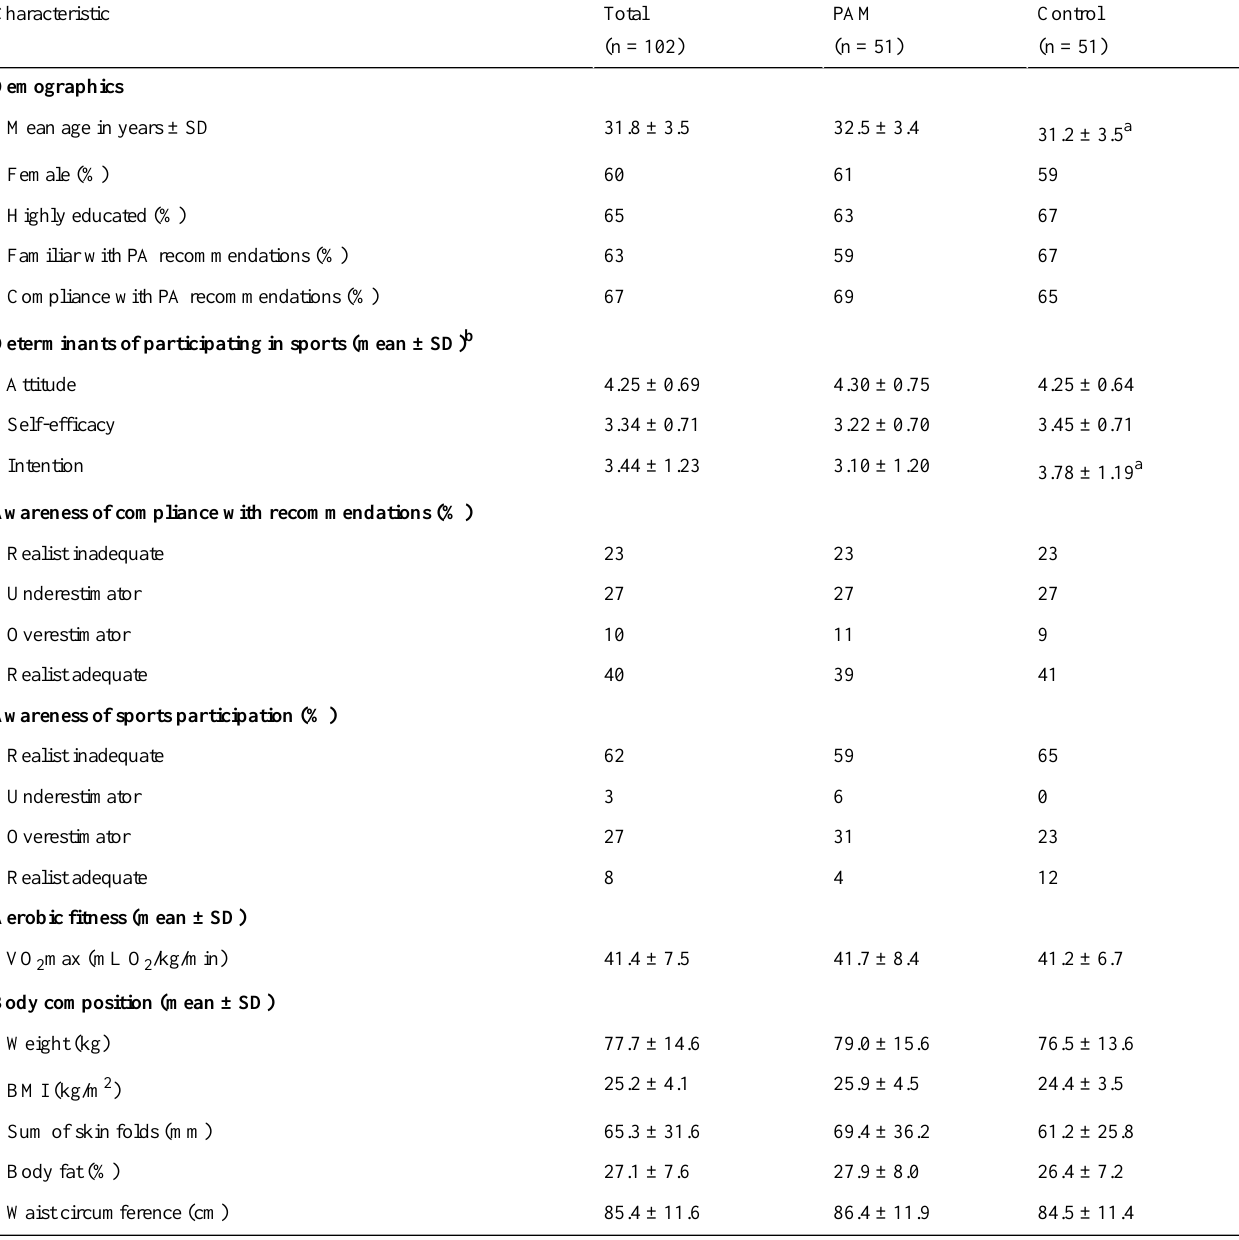
Table 2. Baseline characteristics of total sample, PAM intervention group, and control group